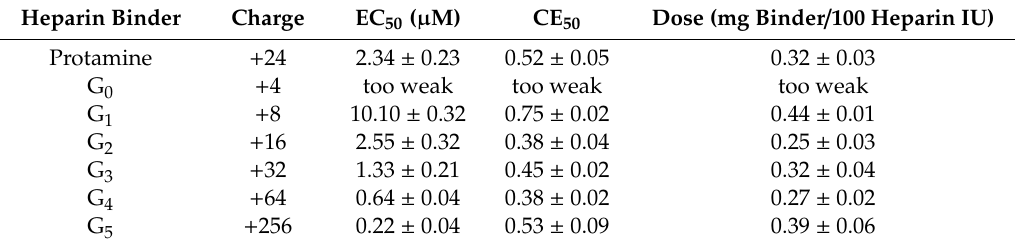
Table A1. EC 50 and CE 50 values for protamine and for ethylenediamine-based covalent PAMAM dendrimers (G 0 -G 6 ) as heparin binders. Values were obtained by fitting the data in Figure 2a. The last column shows the relevant dosage, i.e., the mass of binder required to bind 100 international units (IU) of heparin (i.e., the clinical standard. Adapted from [33] with the permission of The Royal Society of Chemistry.